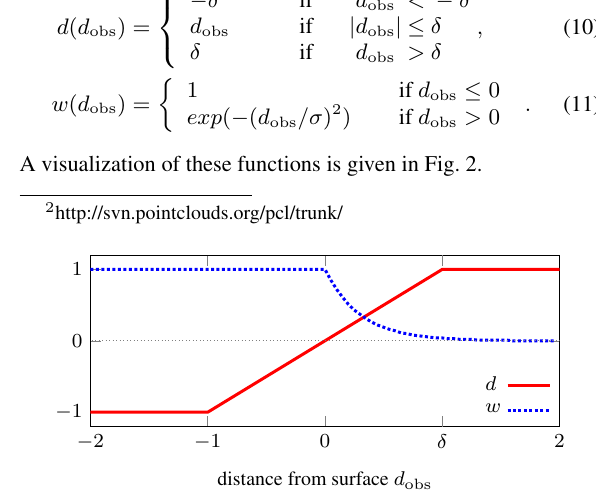
Figure 2: We use a truncated distance function and a weighting function that decreases exponentially behind the observed surface (i.e., for d > 0 obs